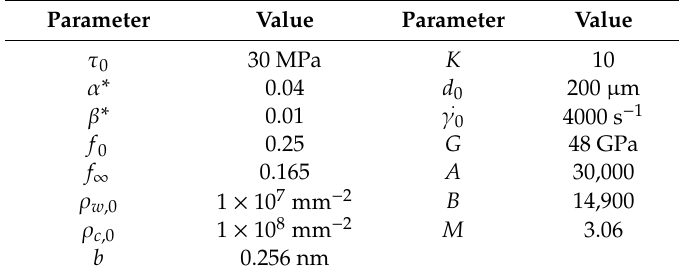
Table 2. DDB model parameters for coarse-grained OFHC copper